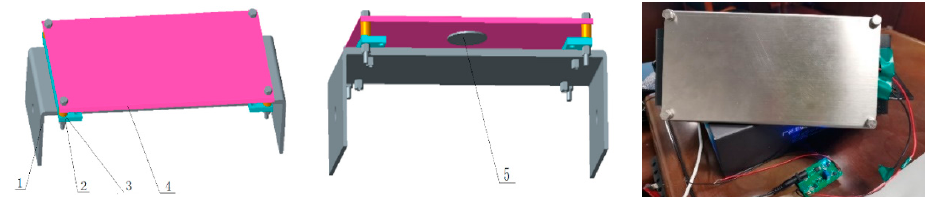
Figure 2. Impacting signal acquiring mechanism. ( 1 ) Frame, ( 2 ) basic plate, ( 3 ) anti-vibration rubber pad, ( 4 ) sensitive plate, and ( 5 ) piezoelectric sensor.